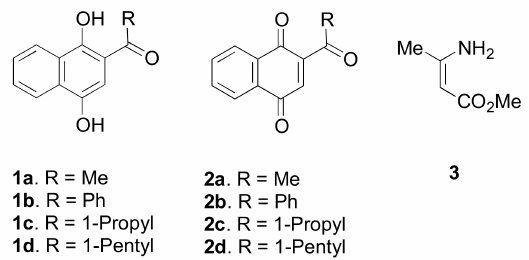
Figure 2. Structure of the quinone and enaminone